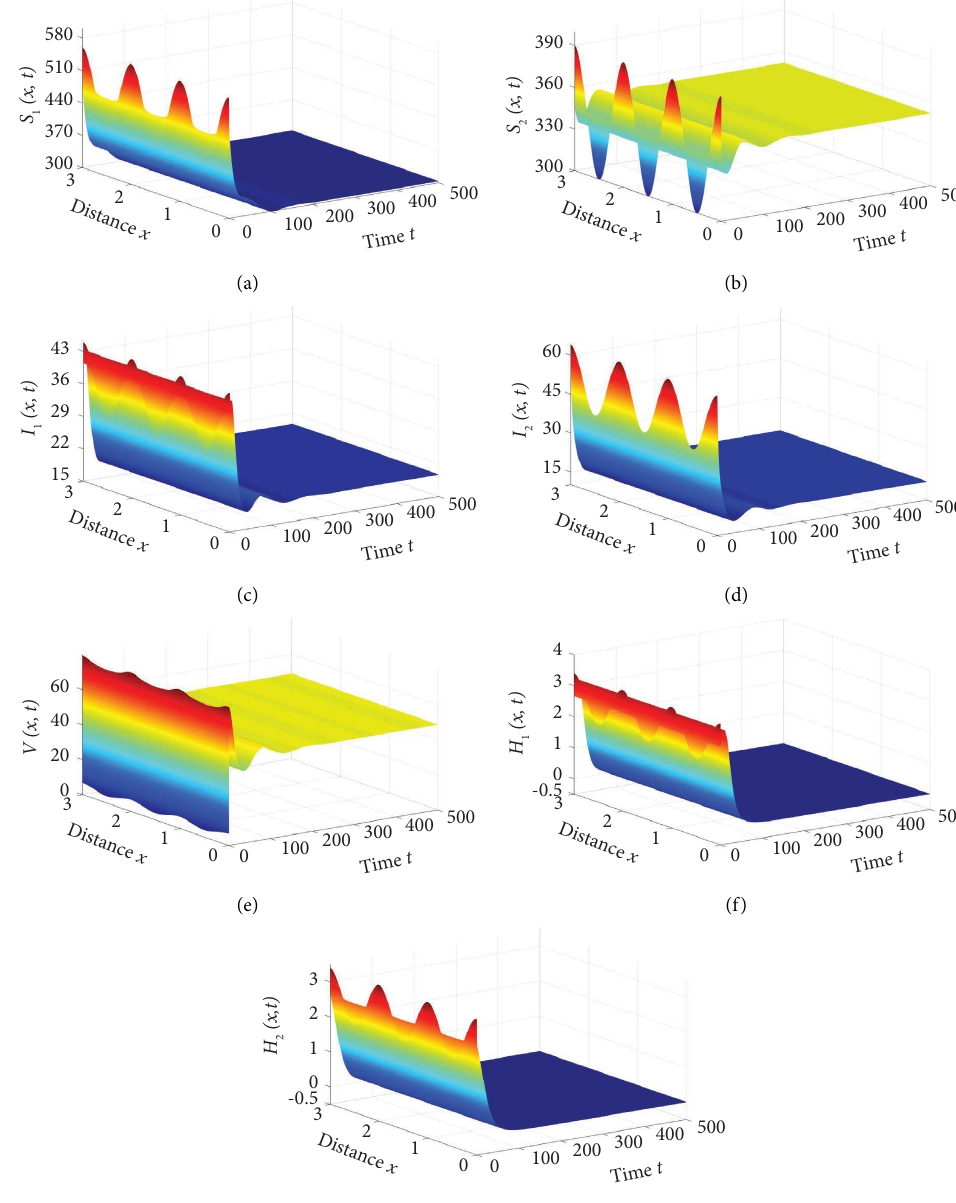
Figure 2: Solution of system (75) with the initial conditions (77), for Case II. R ( 303 . 6858 , 352 . 1369 , 19 . 7542 , 17 . 1795 , 48 . 7863 , 0 , 0 ) is G.A.S. (a, b) Target cells. (c, d) DENV-infected cells. (e) DENV particles. (f) Heterologous antibodies. (g) Homologous